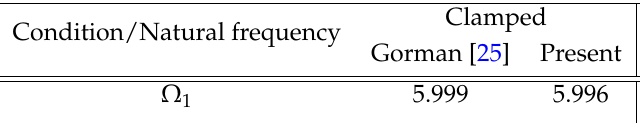
Table 4. Validation of results